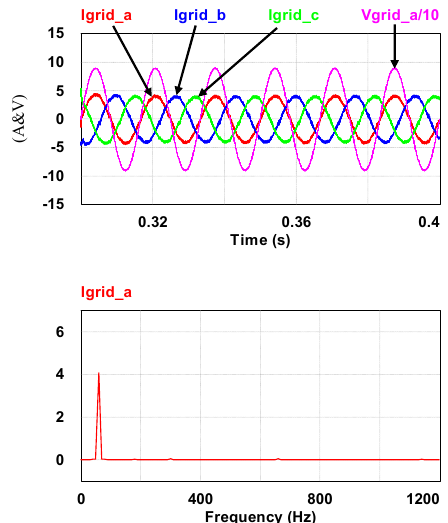
Figure 15. After t 1 : the grid phase-a voltage and three-phase currents/FFT waveform of the grid phase-a current.